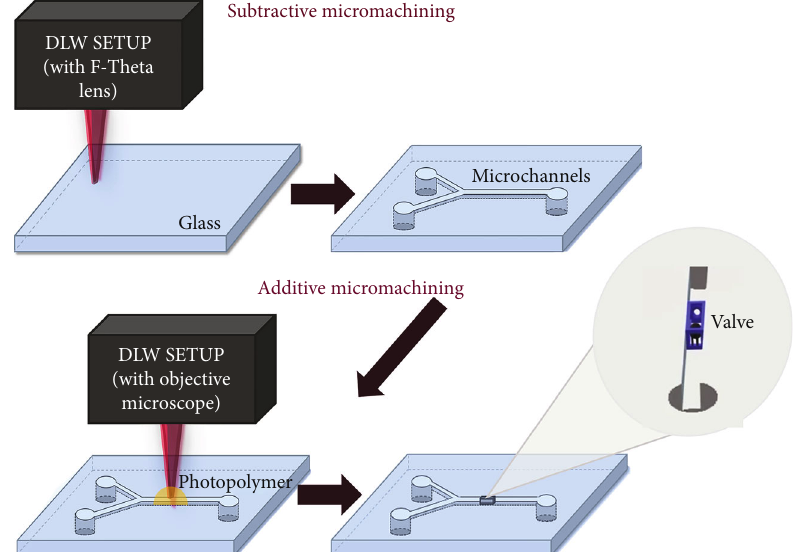
Figure 1: Simpli fi ed diagram of the manufacturing process. In the upper part, the laser writing process of the microchannel in glass. In the lower part, the laser writing of the valve inside the